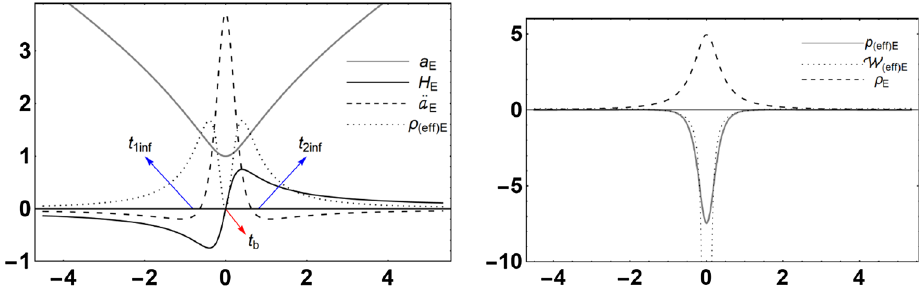
ter energy density for model E . The model parameters have been set as, M = 0 . 6, α(cid:16) E = − 0 . 011 and Z = 1